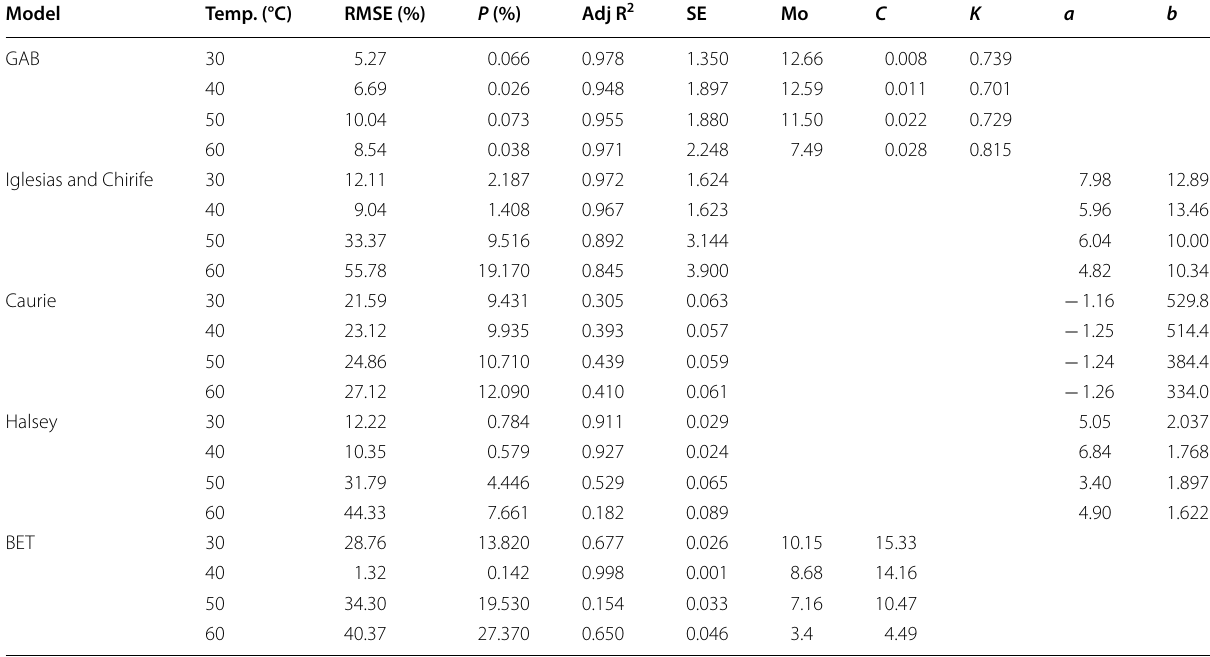
Table 3 Parameters of sorption models and goodness of fit values for experimental temperatures of karaya gum